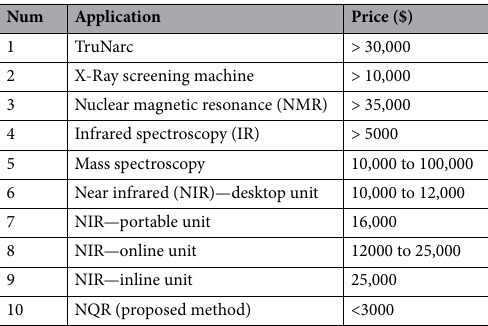
Table 1. Comparison of different authentication models currently being used for detecting illegal